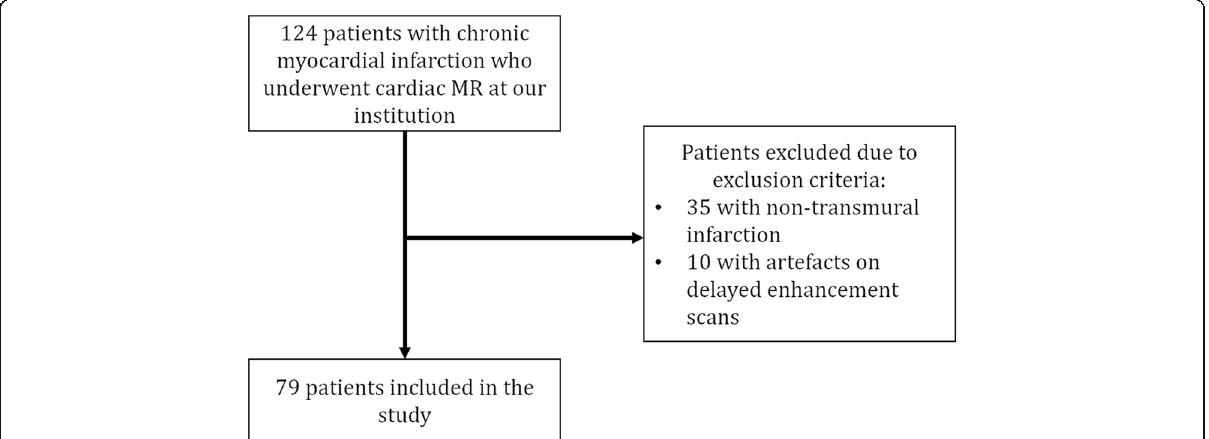
Fig. 2 Study flowchart. Out of 124 initially retrieved patients, 35 were excluded due to their infarction not being transmural and 10 due to artefacts on late gadolinium enhancement scans regardless of the size of their